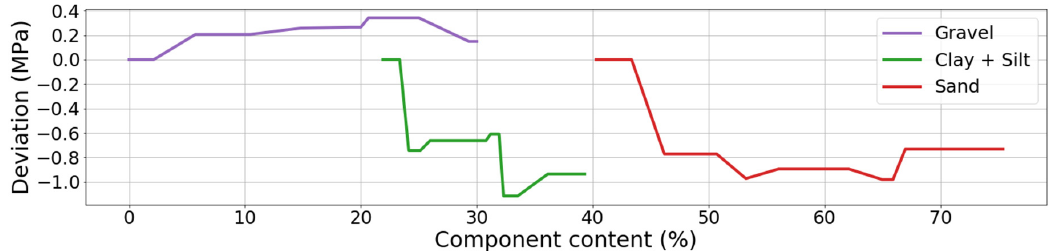
Figure 10. ALE plots for clay+silt, sand and gravel content based on DTR.